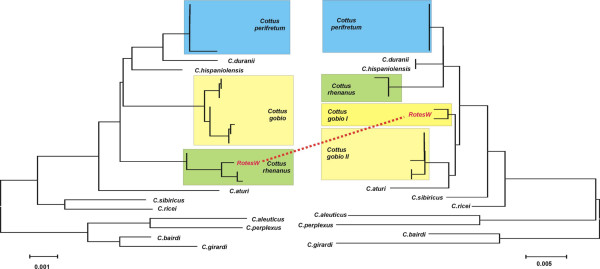
A comparison between LSU and mtDNA sequences with respect to species level resolution for the genus Cottus. Twelve species of the genus Cottus were sequenced for both markers and trees were obtained via the neighbour joining algorithm in MEGA 3.1. For three species, multiple animals from given populations were sequenced. Both markers detect the same groupings, with the exception of the animals from the population "RotesW", where COI sequences generate a different assignment. Further analysis of this case has shown that this is due to mitochondrial transfer.